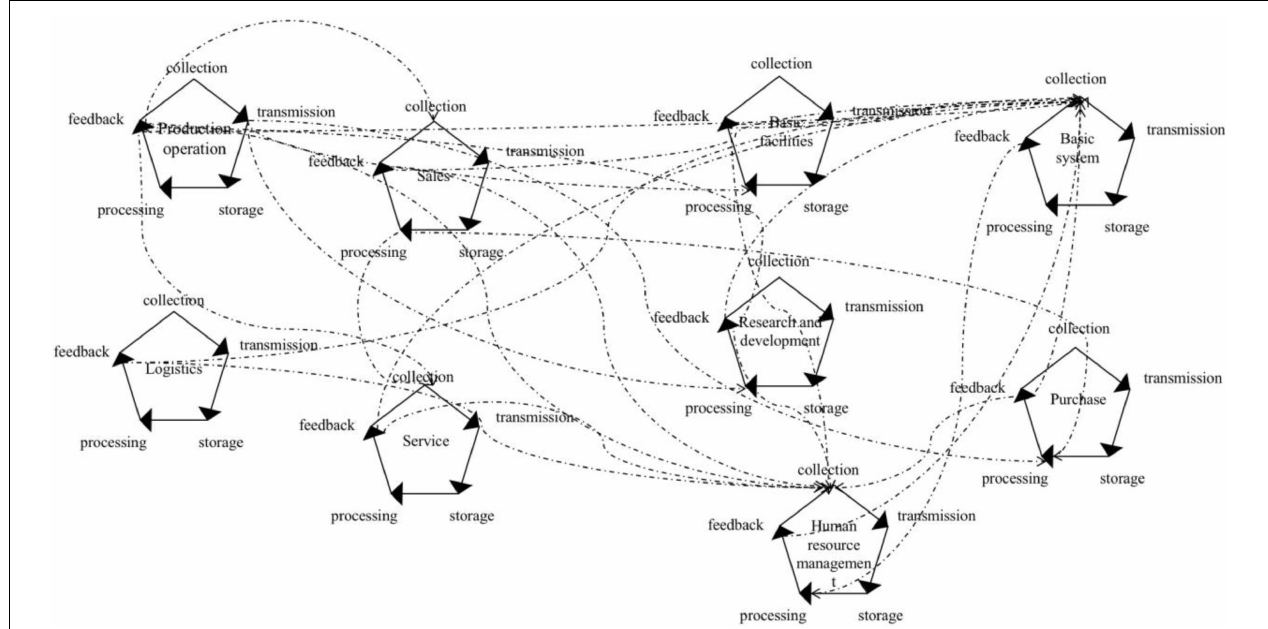
FIGURE 3 | Value chain